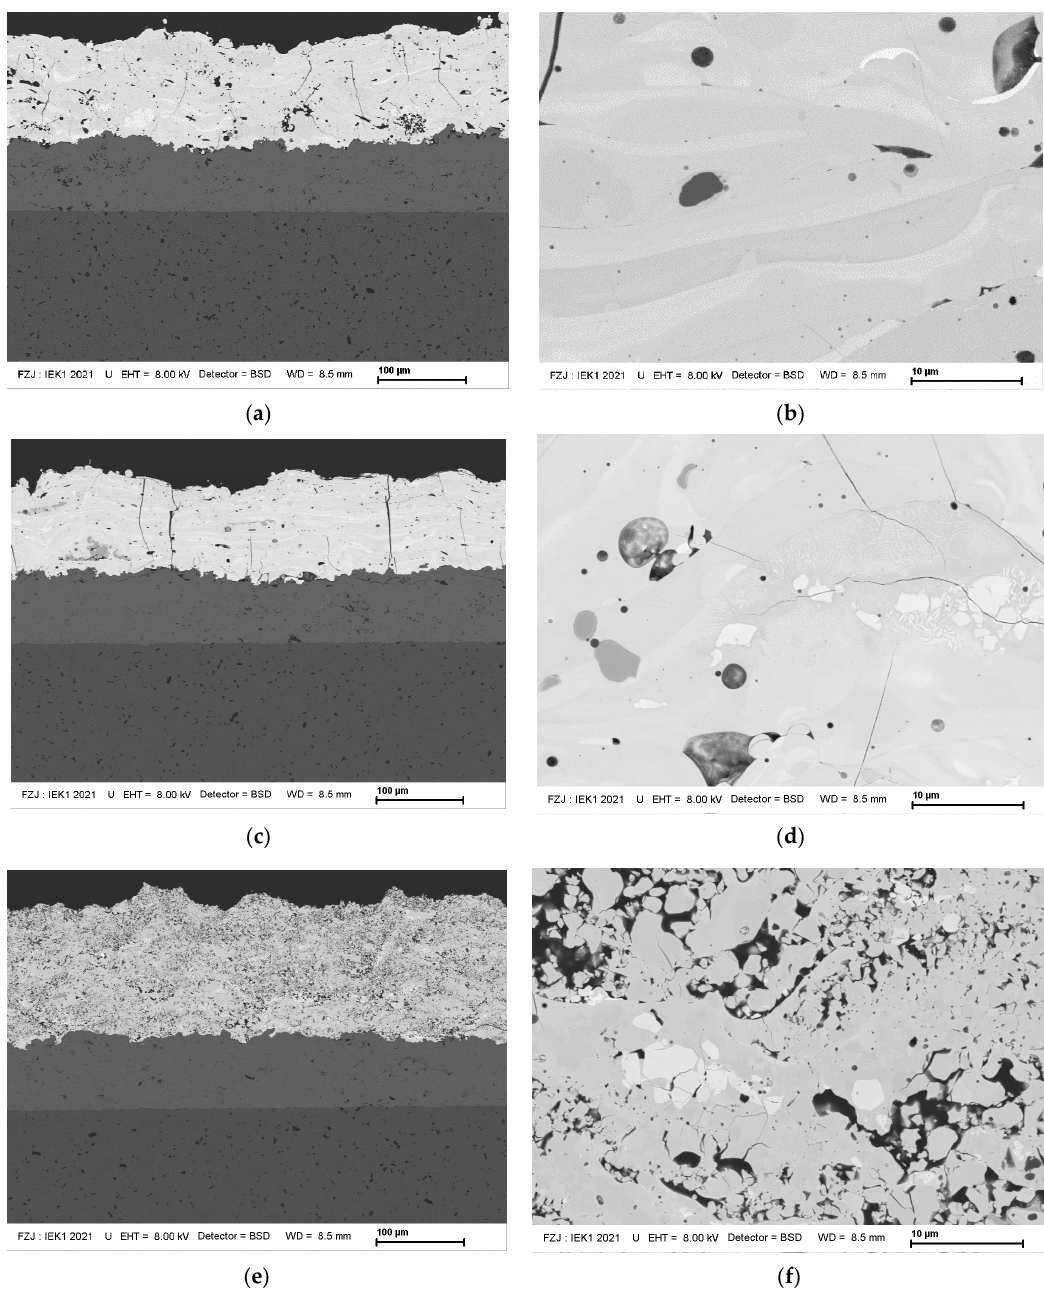
Figure 1. SEM micrographs of as-sprayed YDS coatings, ( a , b ) APS1, ( c , d ) APS2, ( e , f ) HVAPS1.